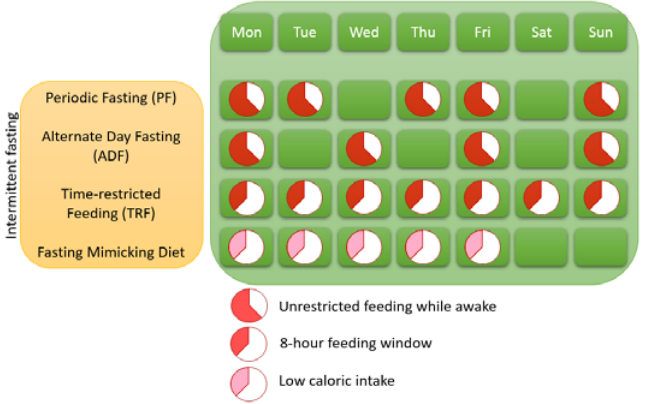
Figure 1. Different forms of intermittent fasting.